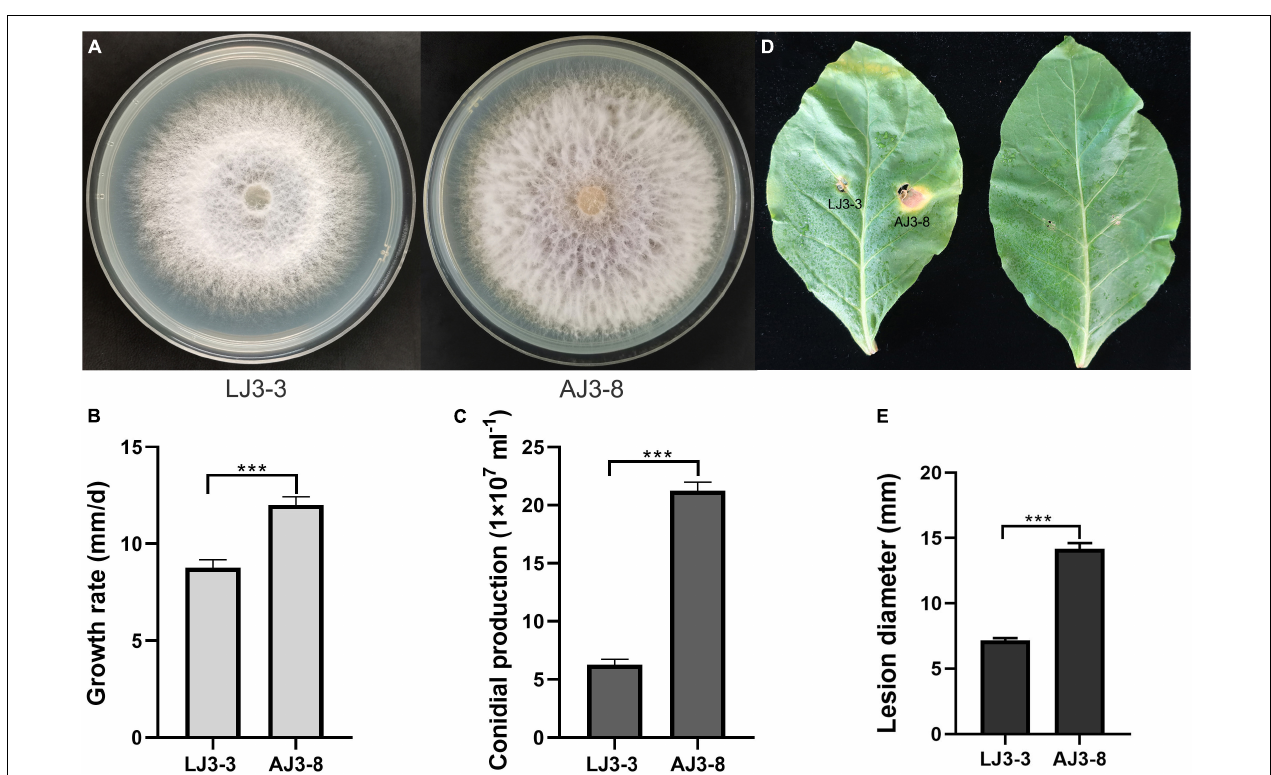
FIGURE 1 | The comparison of different biological characteristic of strain LJ3-3 and AJ3-8. Culture morphology (25 ◦ C, 10 days) (A) and pathogenicity assay (28 ◦ C, 13 days) (D) of Fusarium oxysporum strain LJ3-3 and AJ3-8 on PDA medium and detached Zhongyan 100 leaves, respectively. Comparison of radial mycelial growth rate (25 ◦ C) on PDA (B) , conidia production (28 ◦ C, 180 rpm, right) in CMC (C) , and lesion diameter (28 ◦ C, 13 days) on detached Zhongyan 100 leaves (E) of strain LJ3-3 and AJ3-8, respectively. “***” indicates a significantly different ( p < 0.05) between strain LJ3-3 and AJ3-8 in radial mycelial growth rate, conidia production, and lesion